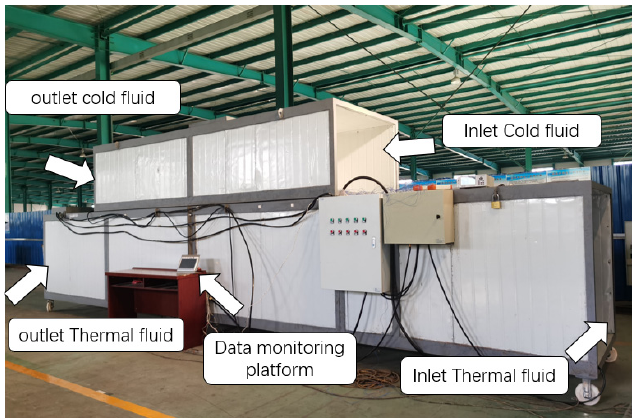
Figure 2. Gravity heat pipe heat transfer experiment equipment.